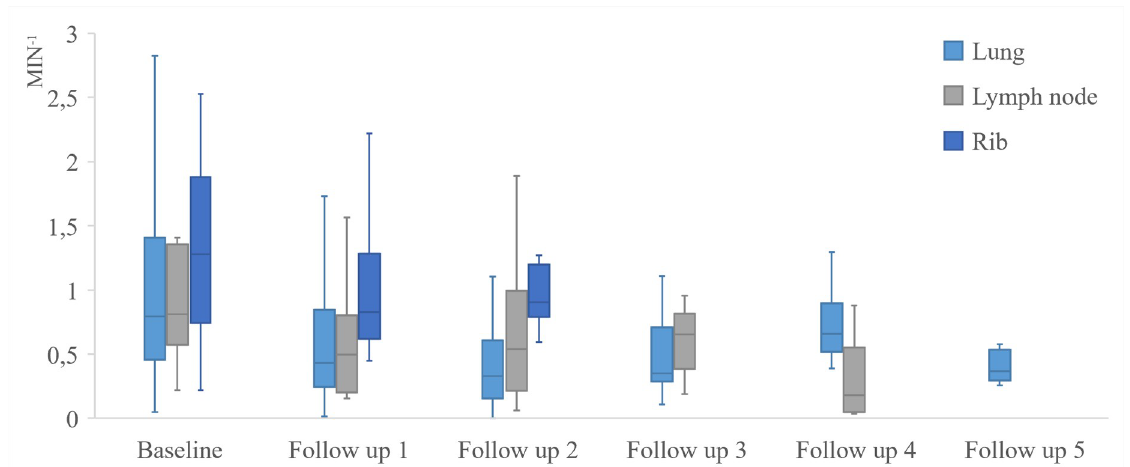
Fig 3. Distribution of K trans values. Boxplot showing the median, the 25th and 75th percentiles respectively the 1.5 interquartile range below the 25th and above the 75th percentile of K trans (min -1 ) during therapy with Erlotinib and Bevacizumab.